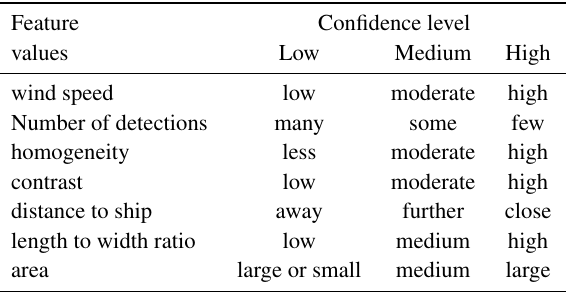
Table 2. Feature guideline as observed manually and through literature